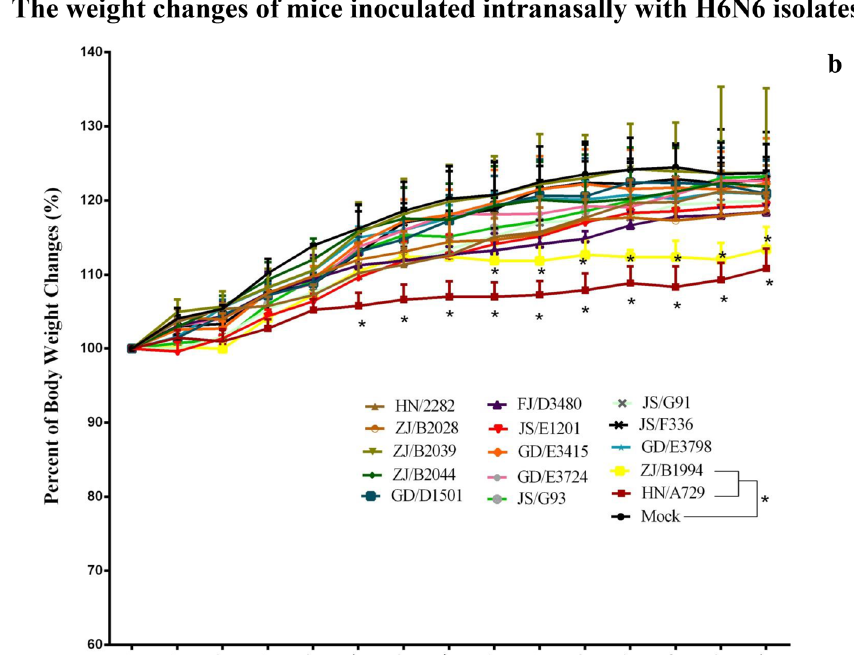
of all three mice, the remaining H6N6 viruses were detected in some inoculated mice. All of the H6N6 isolates were detectable in the hearts of some to all of the three inoculated mice, except ZJ/B2039/H6N6, GD/E3798/